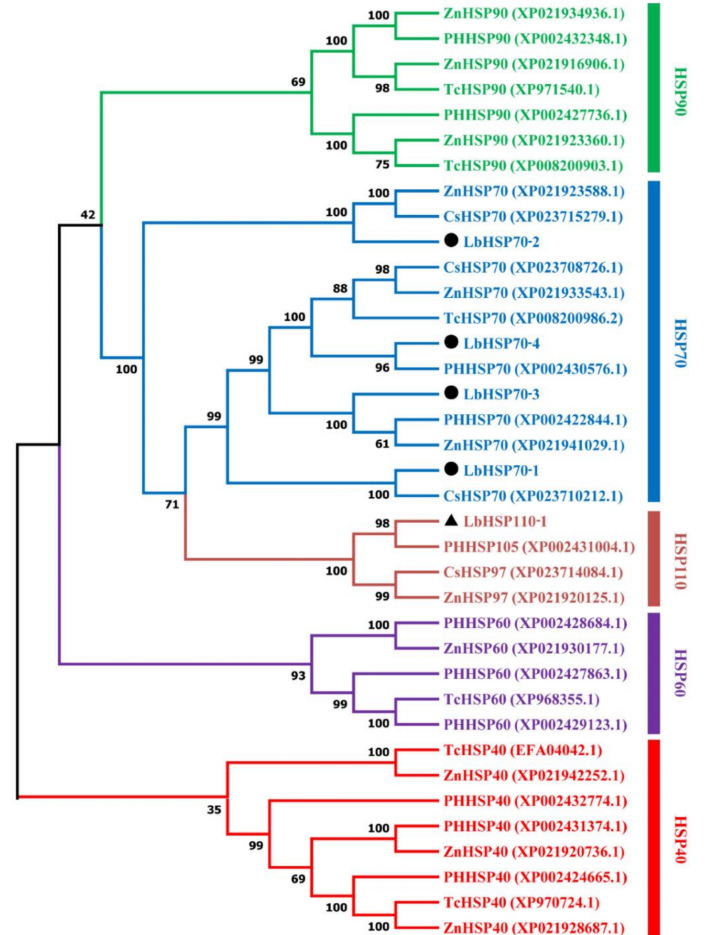
Figure 3. Neighbor-joining phylogenetic tree of LbHsps with other insects. The LbHsp70s are labeled with a black circle and LbHsp110-1 with a black triangle. Numbers on the branches are the bootstrap values obtained from 1000 replicates. Sequences were downloaded from